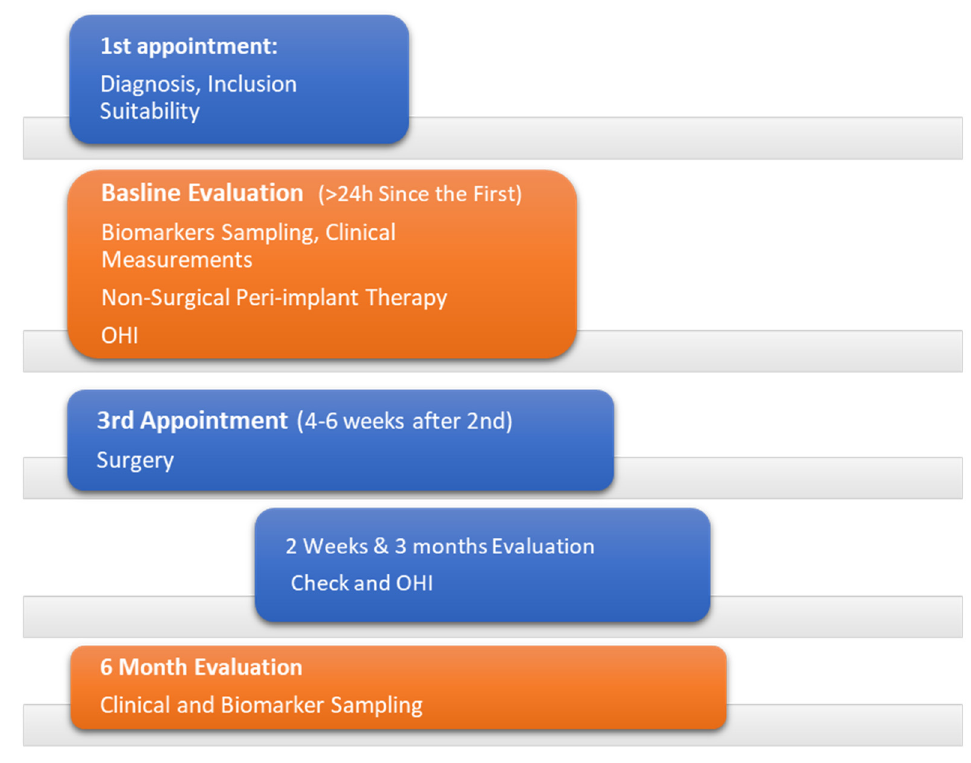
Figure 1. Treatment Timeline.